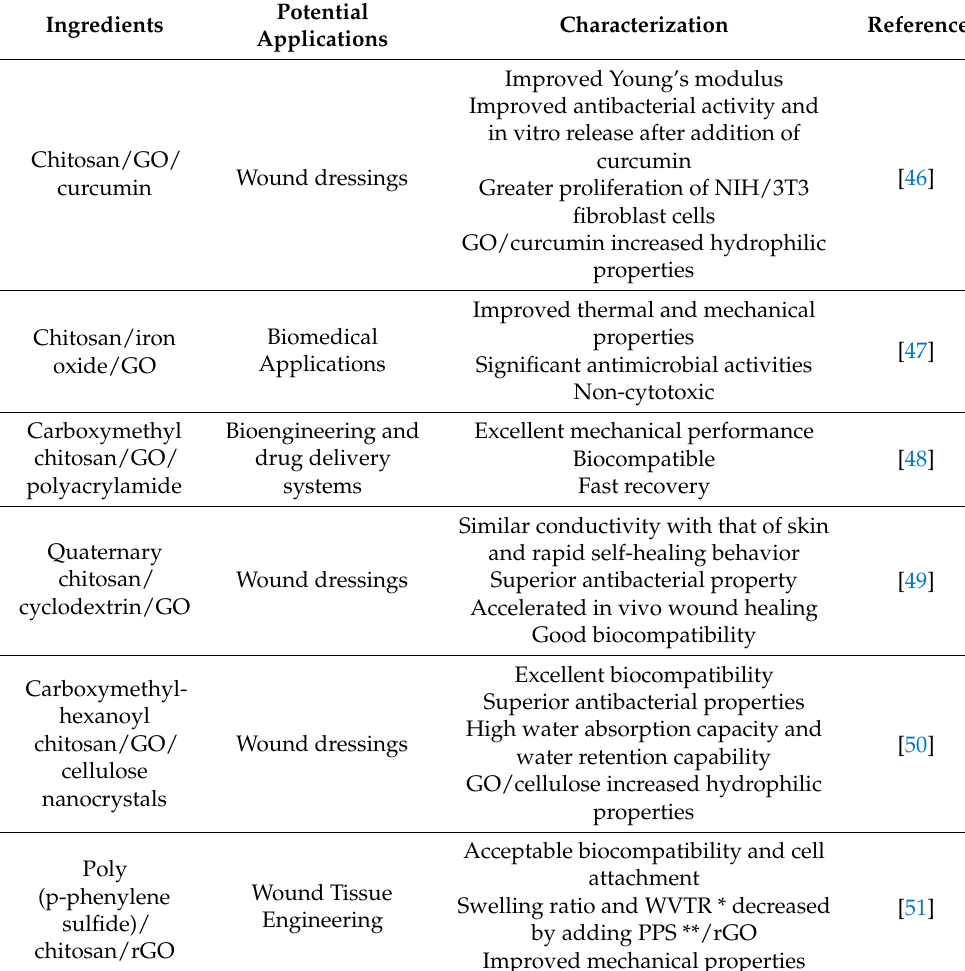
Figure 5. Photographs of pH-driven shape memory polymer samples ( a ) CS/5 wt% GO and ( b ) pure CS. The CS strip was coated with methylene blue for better visibility. OS: original sample [45]. Several other studies involving the preparation of chitosan/GO hydrogels are listed in Table 1. Table 1. Chitosan/GO hydrogels and their biomedical